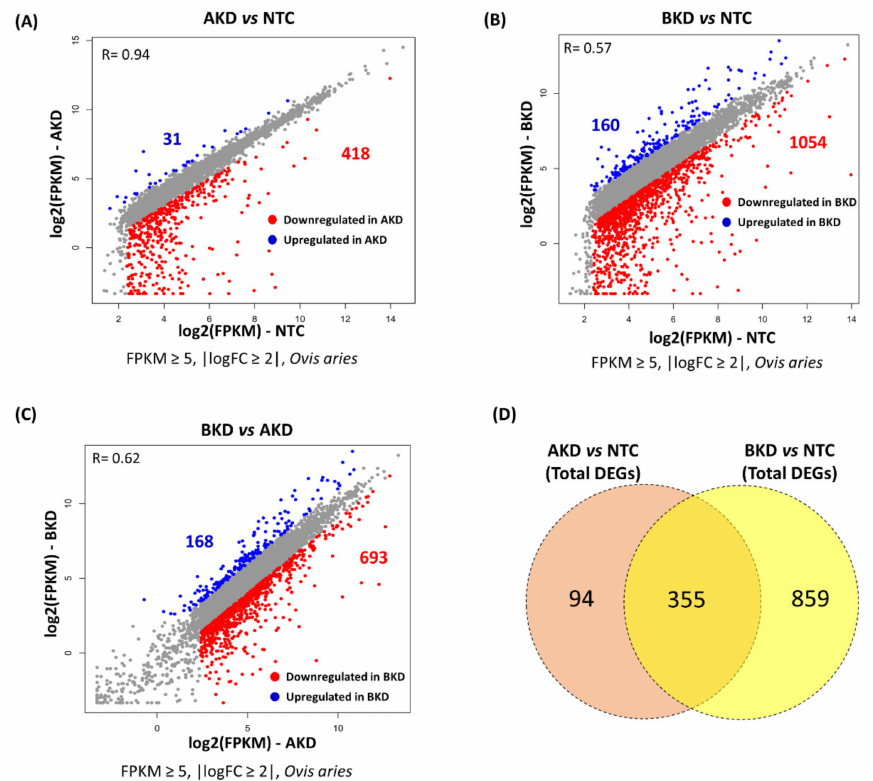
Figure 2. Scatter plots to identify the DEGs in: ( A ) AKD vs. NTC, ( B ) BKD vs. NTC, and ( C ) BKD vs. AKD, with cut-off criteria of FPKM ≥ 5, |logFC ≥ 2|. The red dots represent downregulated genes, the blue dots represent upregulated genes, and the grey dots represent the genes that did not show any change between different groups. ( D ) Venn plot comparing the total DEGs in AKD vs. NTC and BKD vs.